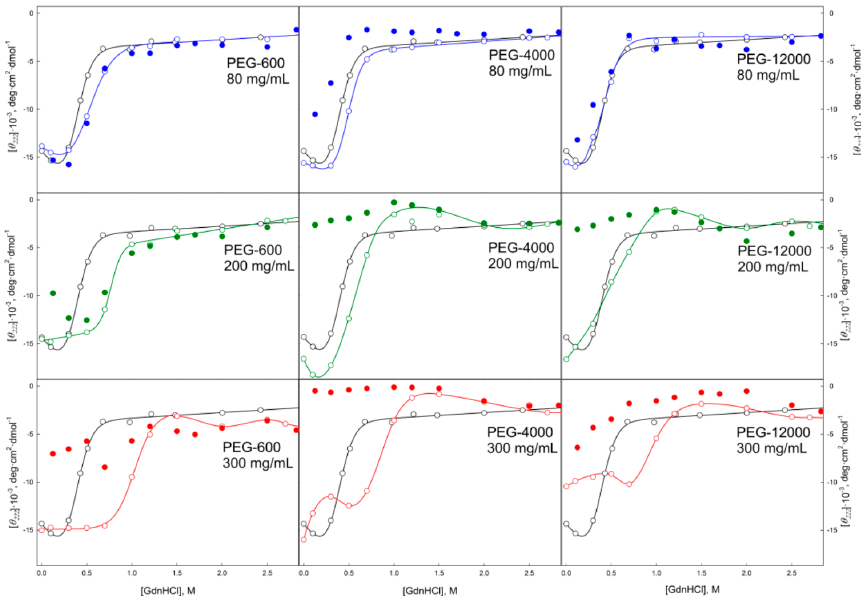
Figure 10. Unfolding/refolding transitions of GGBP in the presence of different concentrations of PEGs with different molecular weight recorded as dependence of GGBP molar ellipticity at 222 nm on GdnHCl concentration. The designations as in Figure 4.